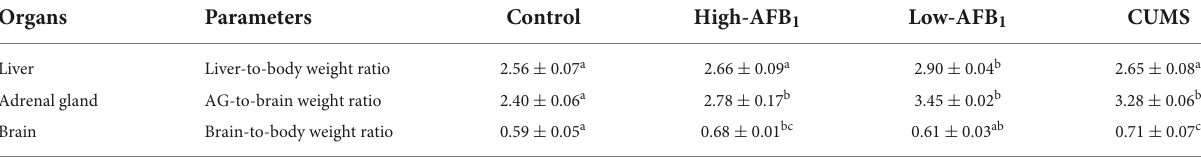
TABLE 1 Relative weights of liver, adrenal glands, and brain of rats in different groups. Organs Parameters Control High-AFB 1 Low-AFB 1 CUMS Liver Liver-to-body weight ratio Adrenal gland AG-to-brain weight ratio Brain Brain-to-body weight